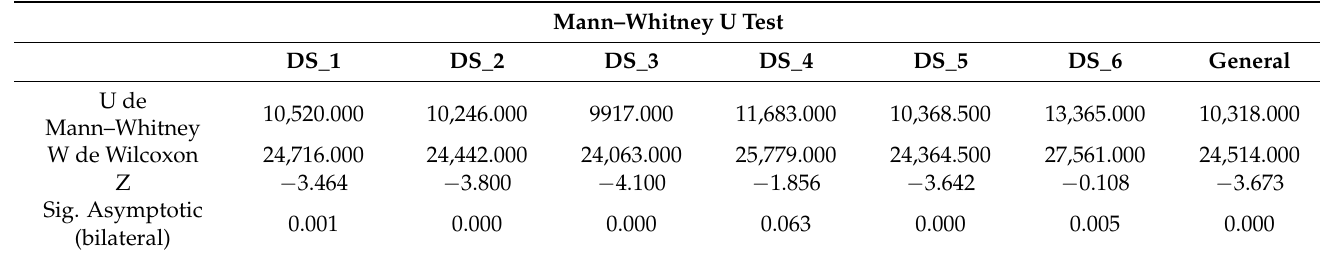
Table 6. Mann–Whitney U test with no-COVID-19/COVID-19 variable (pre-test).